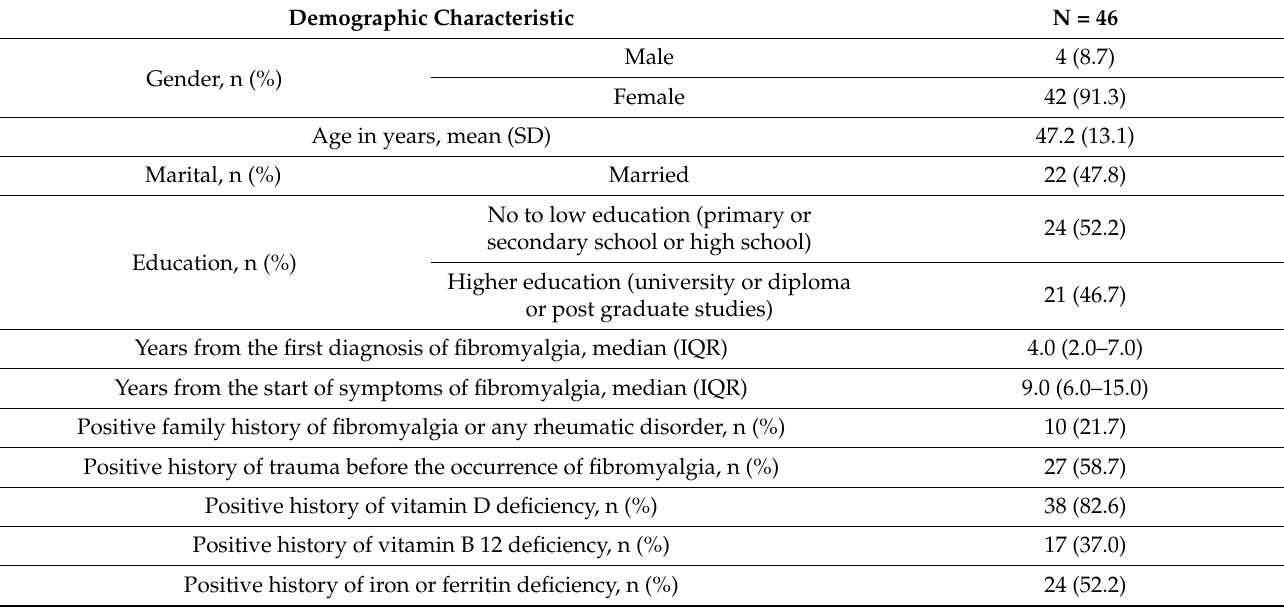
Table 1. Participants’ demographic